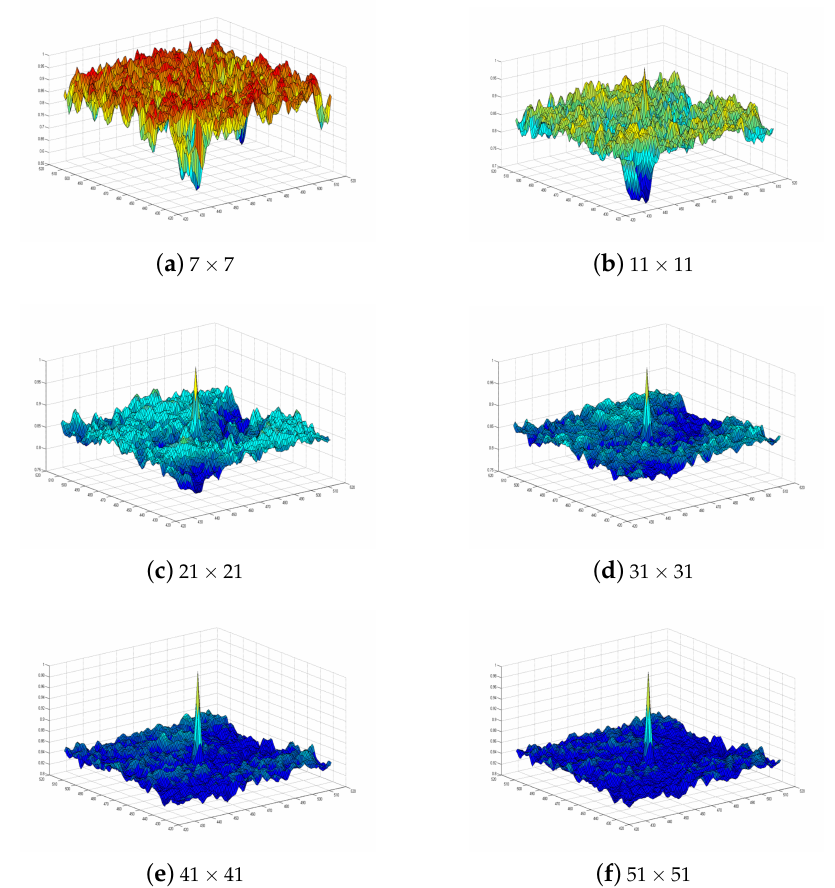
Figure 20. Correlation coefficient grid diagram of different